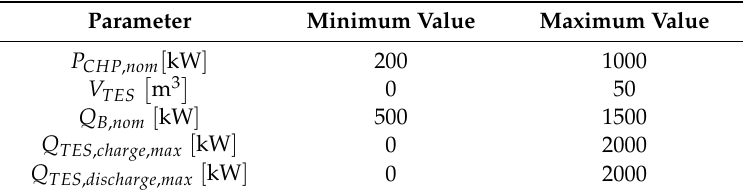
Table 4. Range of values of the design variables.